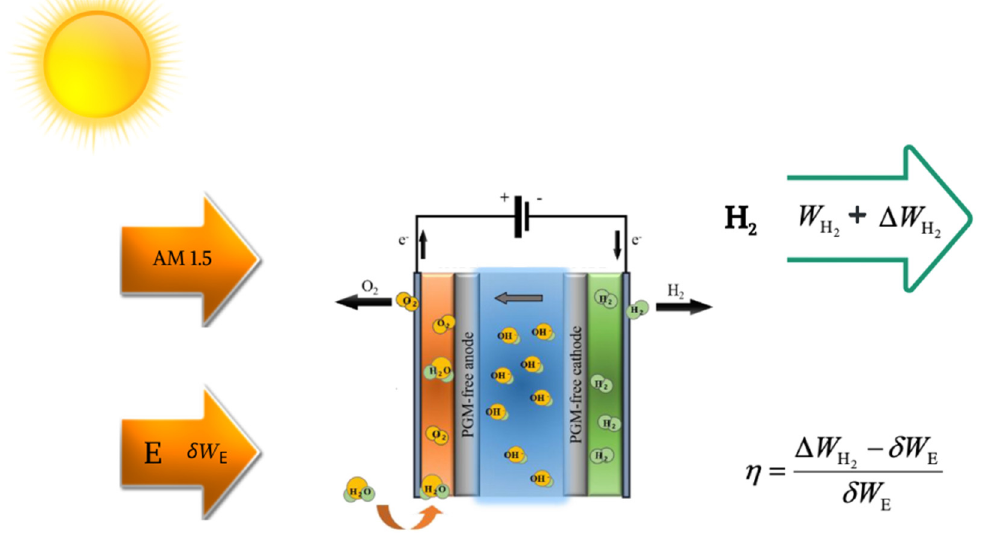
Figure 4. Prototype PEC cell, irradiated by AM 1.5 source (from the left), with NaOH solutions [17,74]. W H2 is the energetic equivalence of H 2 emanating from PEC action without any field applied by photo-current. Δ W H2 denoted the extra energy equivalent of hydrogen generated via action of the applied field, E, together with its energy input, δ W E . η is an “efficiency” of extra energy output relative to the electric field’s input (see main text). For application in the DC case, this was performed typically across the side receiving the light, with each static field electrode joined to the middle screws at either end of this side [17,74]. In the case of the unit cm 2 anode for 1 M NaOH, the “trans-face” field application was accompanied by “face − to − face”, in which case electrodes were held by screws on sides near and at the far end from the source; for further details, the reader is referred to refs. [17,74].